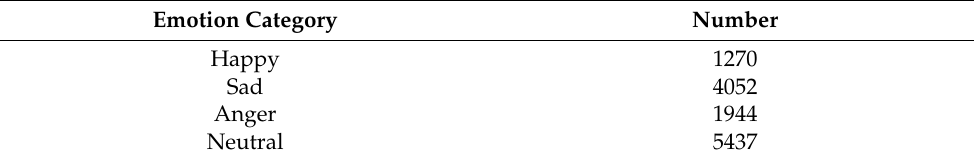
Table 2. Categorical emotion distribution of IEMOCAP after segments of four